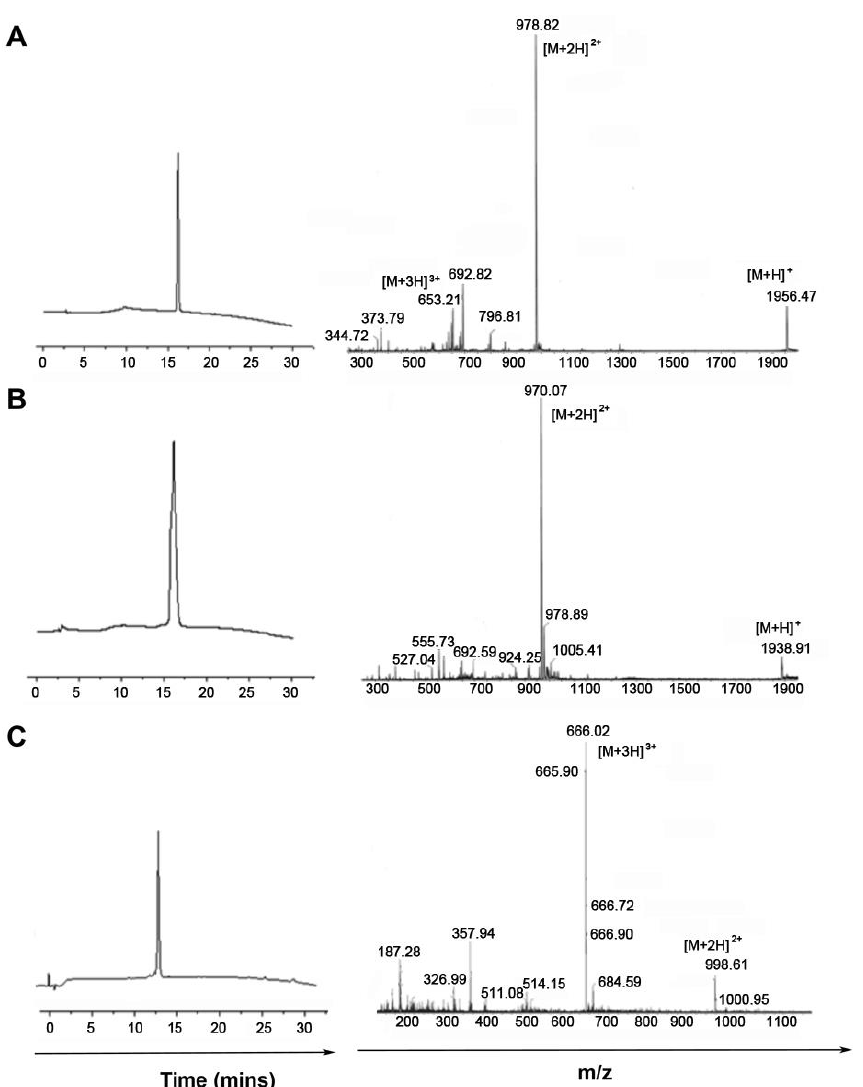
Figure 1. Analytical HPLC (left) and electron spray ionization mass spectrometry (ESI-MS) (right) of purified lyophilized ( A ) linear MBP 82–98 (Ala 91 ) peptide, ( B ) cyclic MBP 82–98 (Ala 91 ) peptide and ( C ) cyclic MBP 82–98 peptide (solvent A: 0.1% trifluoroacetic acid in H 2 O, solvent B: 0.1% trifluoroacetic acid in ACN). Column Nucleosil RP-C18 RP, seven µm.